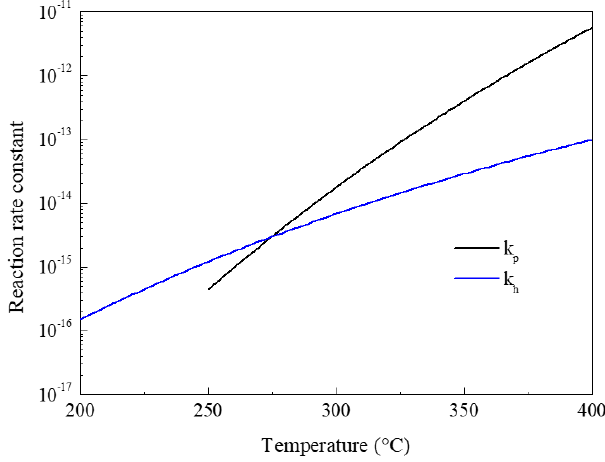
Figure 4. Reaction rate constant of TTIP pyrolysis and hydrolysis reactions under different temperatures.